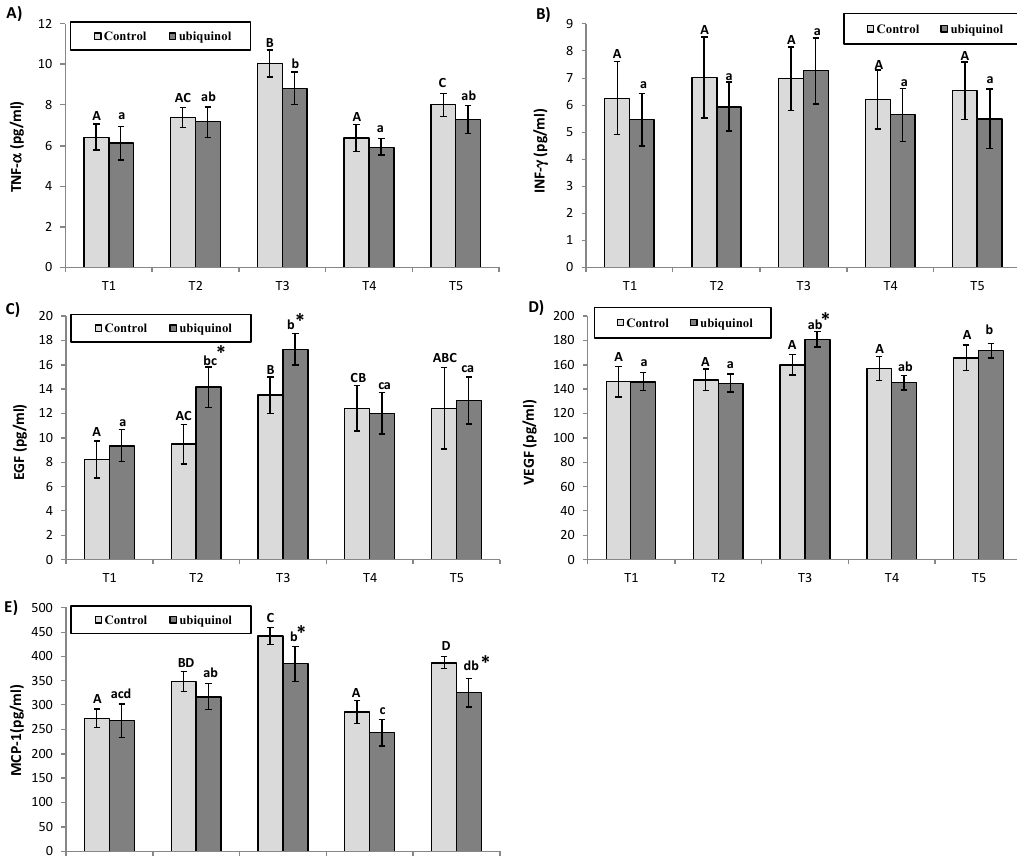
Figure 2. E ff ects of exercise and ubiquinol supplementation on plasma cytokines: tumor necrosis